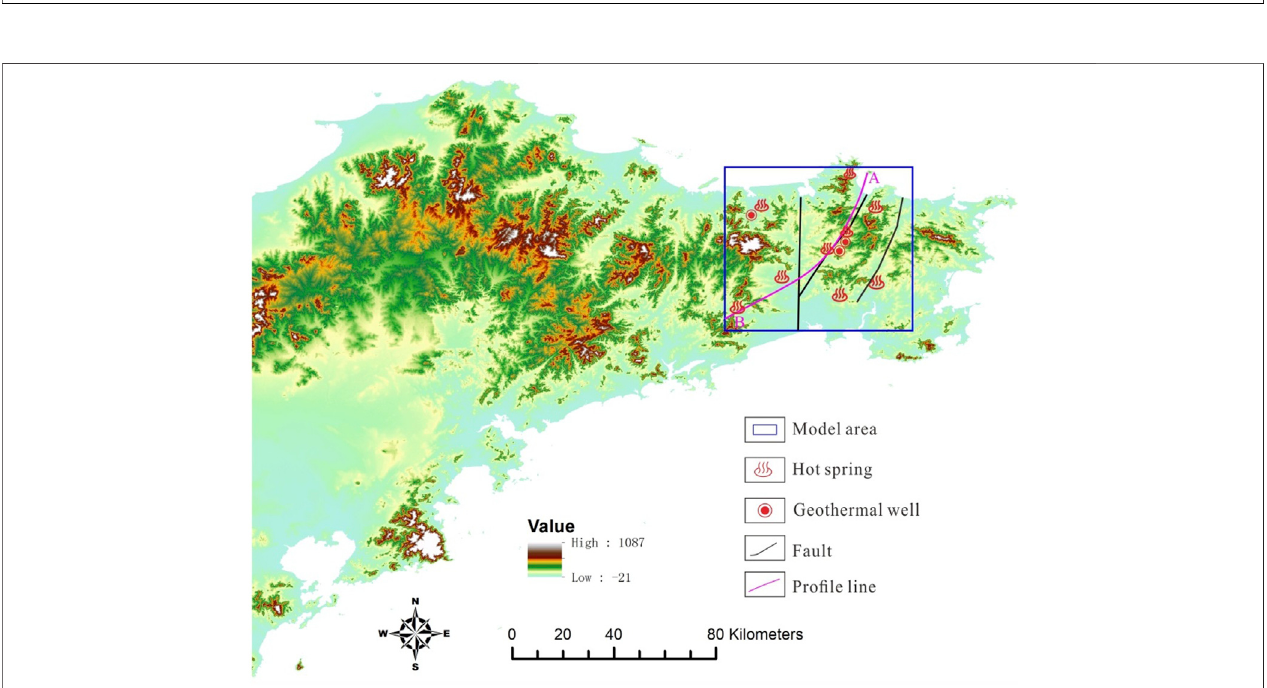
FIGURE 7 | Modeled area of the Weihai uplift.